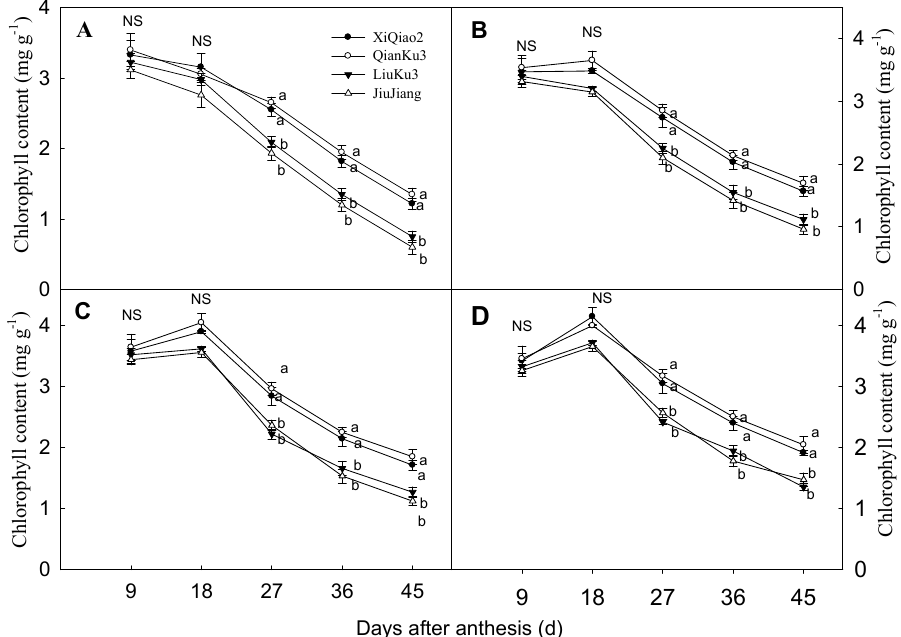
Figure 1. Chlorophyll (Chl) content in the leaves of four Tartary buckwheat cultivars at different flowering nodes. Panels A , B , C , D show results for leaves of the 6th, 7th, 8th, and 9th flowering nodes, respectively. Data are means ± SD of two years (2016 and 2017). Letters a and b denote significant differences between cultivars ( p < 0.05) in chlorophyll content at the same day after anthesis. NS: no significant difference.